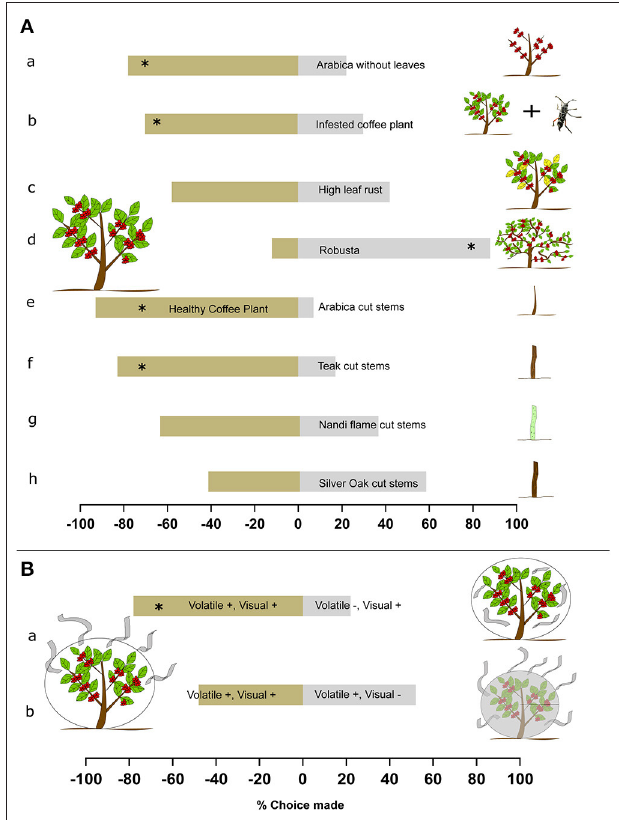
FIGURE 2 | Host preference and cues used by Coffee White Stem Borer (CWSB). (A) Top: CWSB host preference in a 2-choice behavioral bioassay. (a), Healthy coffee plant with leaves vs. healthy coffee plants without leaves ( n = 18) (b), Healthy coffee plant vs. infested coffee plant ( Coffea arabica ) ( n = 22) (c), Healthy coffee plant vs. high leaf rust coffee plant ( n = 19) (d), Healthy coffee plant vs. healthy robusta ( Coffea canephora , n = 69) (e), Healthy coffee plant vs. arabica cut stem ( n = 23) (f), Healthy coffee plant vs. teak ( Tectona grandis ) cut stem ( n = 29) (g), Healthy coffee plant vs. nandi flame ( Spathodea campanulata ) cut stem ( n = 25) (h), Healthy coffee plant ( Coffea arabica ) vs. silver oak ( Grevillea robusta ) cut stem ( n = 26). (B) Cues used by CWSB for host selection. (a), coffee plants ( Coffea arabica ) with both visual and volatile cues present vs. visual cues present but volatile cues reduced ( n = 27). (b), Coffee plants with both visual and volatile cues present vs. volatile cues present but visual cues reduced ( n = 21). * p < 0.05, chi-square test. See Supplementary Table 1 for statistical